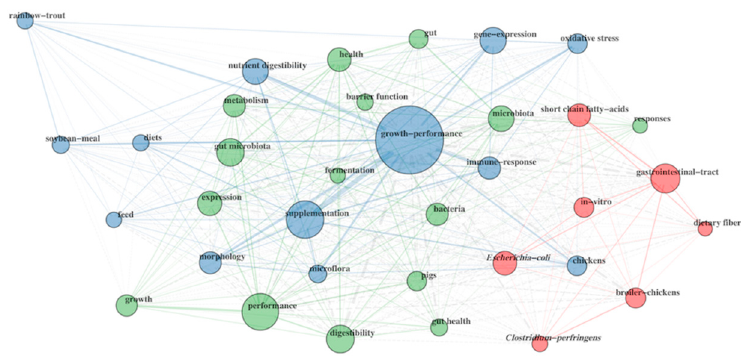
Figure 4. Keyword plus co-occurrence network map.